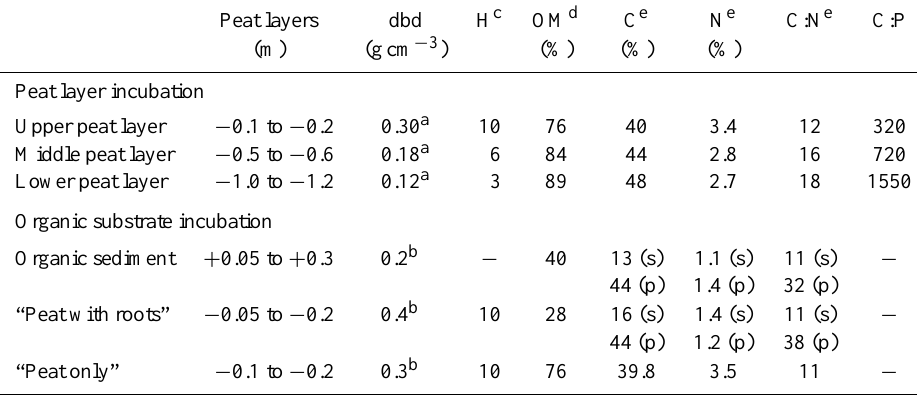
Table 1. Selected peat characteristics for peat from different horizons, as well as sediment/peat substrates incubated in two experiments sampled from the Zarnekow polder (mean, n = 3). Peat layers dbd H c OM d